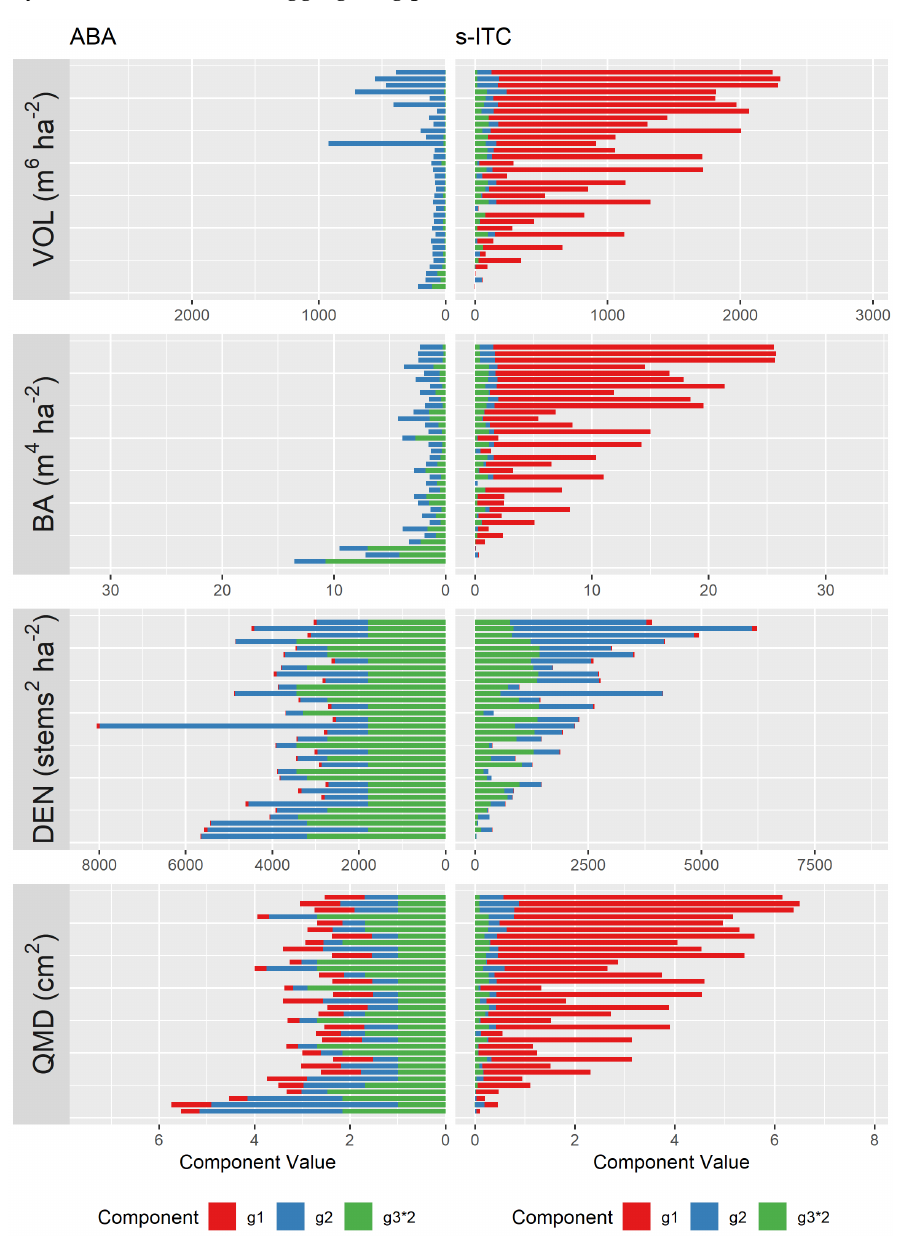
Figure 6. Error components for segment and cell models for VOL, BA, DEN, and QMD in sampled stands. Component rows are ranked by the ratio of the number of segments to the number of field plots (as in Figure 5) in ascending order.